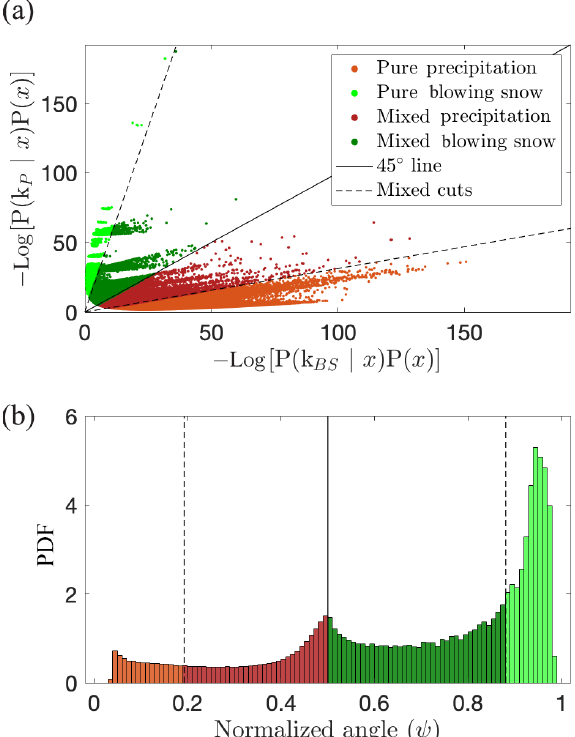
Figure 10. (a) Scatter plot of the quadratic discriminant values of both components for the entire Antarctica 2017 campaign. (b) Dis- tribution of the normalized angle and corresponding